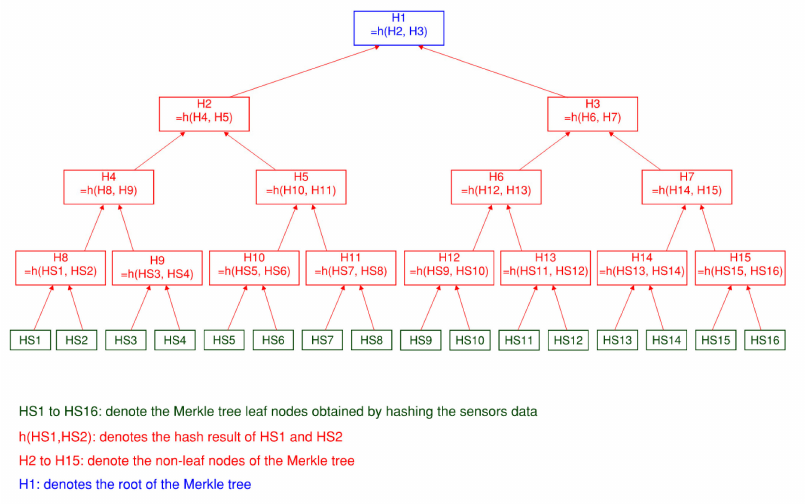
Figure 4. Merkle tree data structure for the sensor data.